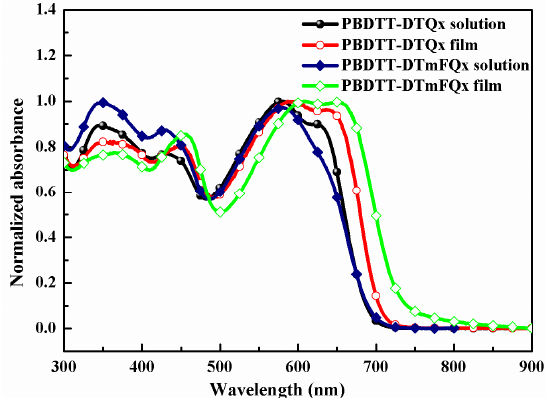
Figure 2. UV-Vis absorption spectra of the copolymers in solution and in thin films.